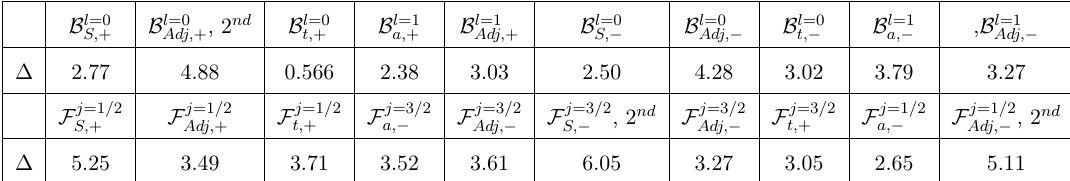
Table 2 . Spectrum of (sub-)leading operators in each channel, estimated at the SU(3) bootstrap jump using extremal functional method. Here“ t ” labels the 27 dimensional representation of SU(3), whose Dynkin label is (2,2), while“ a ” labels the 10+ 10 dimensional representation of SU(3), whose Dynkin label is